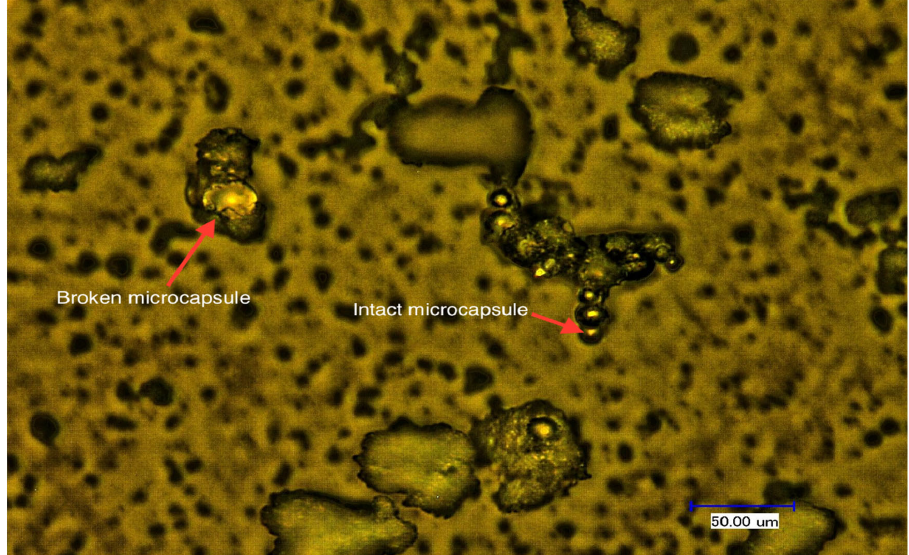
Figure 6. Optical image of a microcapsule with a water:oil ratio of 5.5:1.